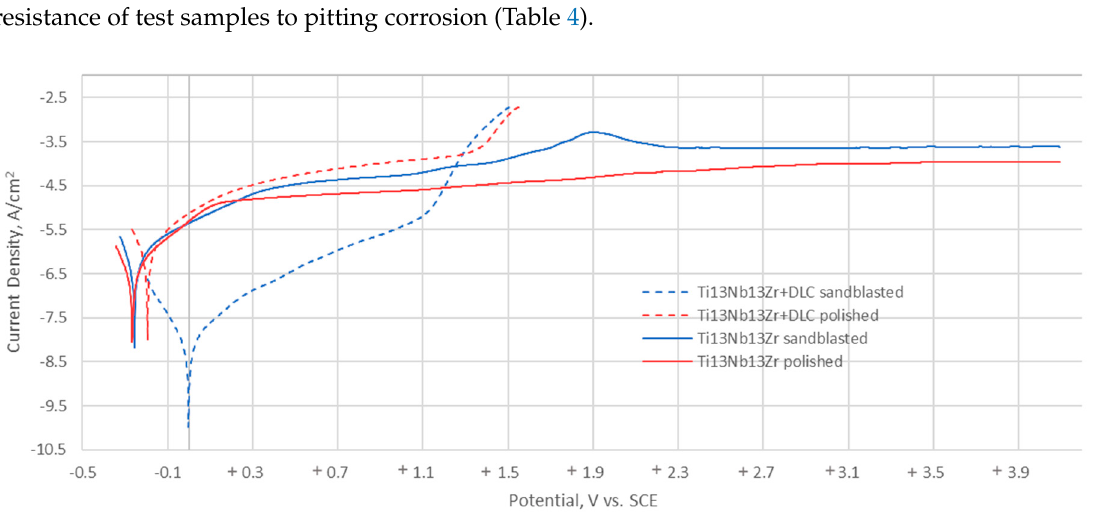
Figure 10. Typical polarisation curves for Ti-13Nb-13Zr and Ti-13Nb-13Zr+DLC.